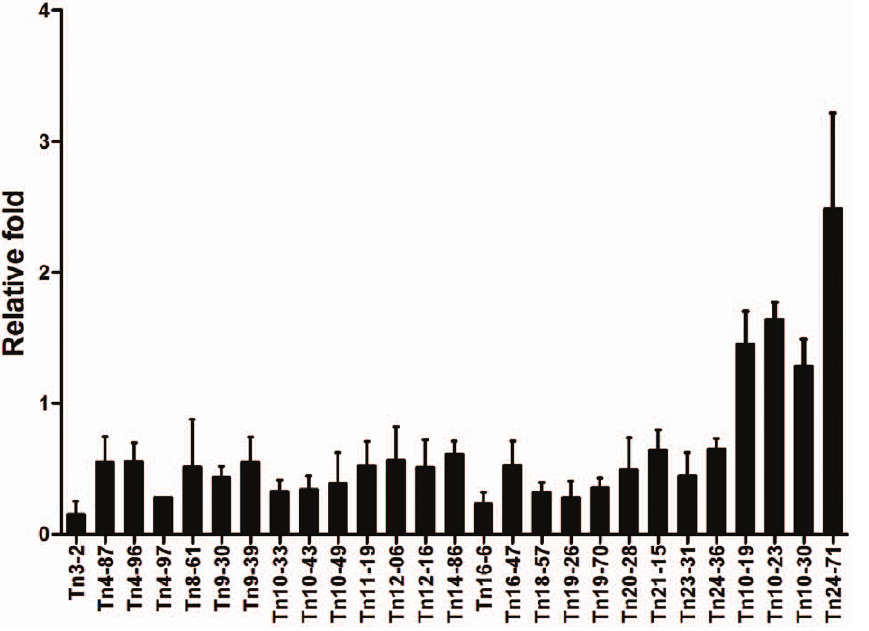
Figure 2. Biofilm formation of transposon mutants of K.pneumoniae NTUH-K2044. Overnight cultures of K. pneumoniae PLA and non- tissue-invasive strains were grown in fresh Luria-Bertani broth at a ratio of 1:100 in polystyrene plates at 37 u C for 5 hr. The sessile bacteria were stained with crystal violet, washed to remove unbound cells, eluted with 95% ethanol, and monitored the absorbance at 550 nm. Data are representative of three independent experiments (duplicate in each experiment).